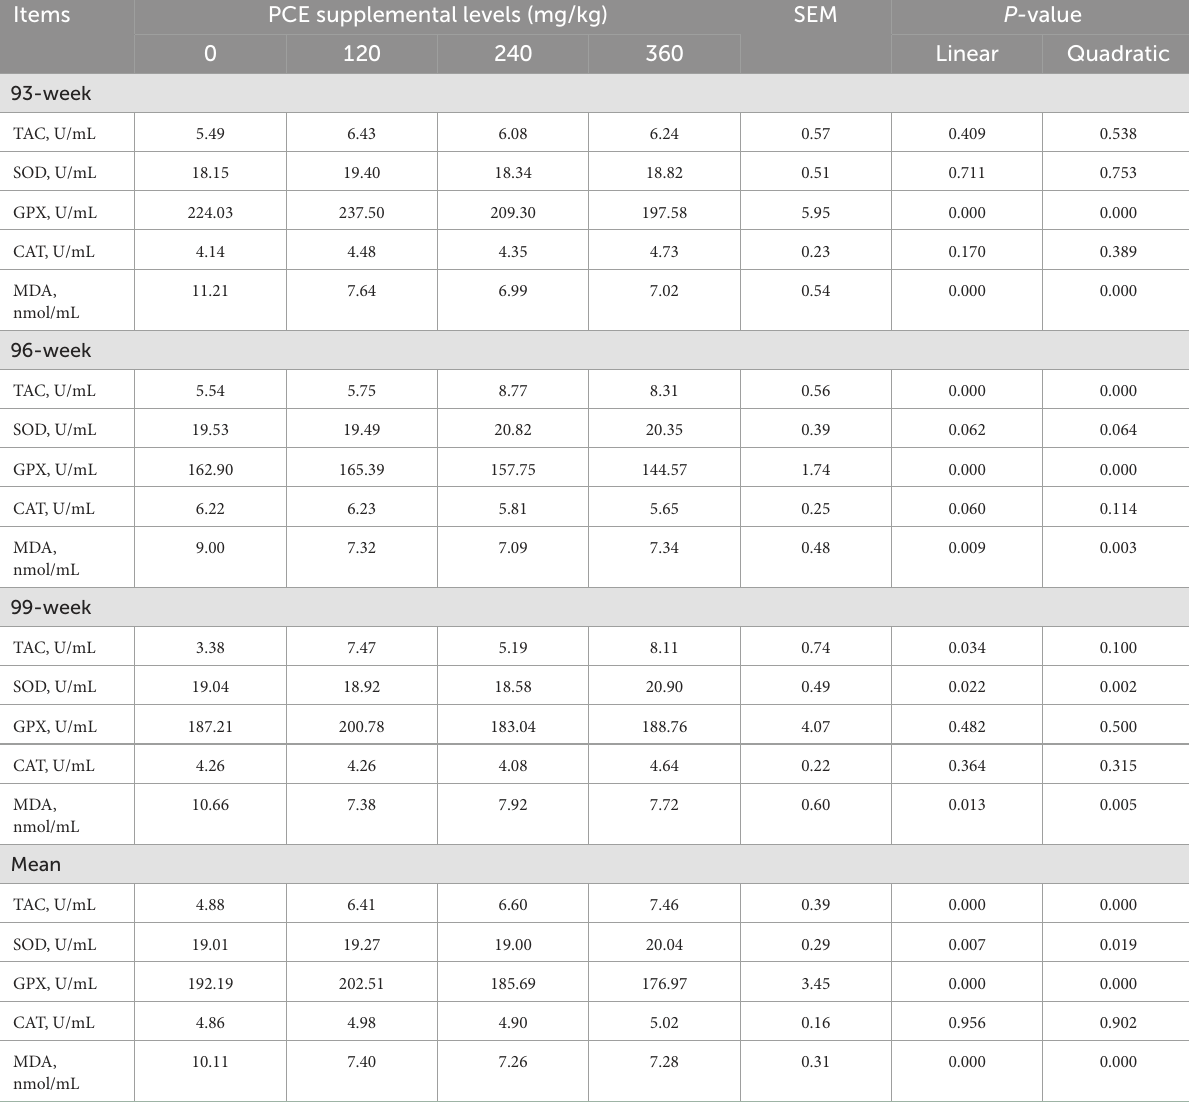
TABLE 3 Effect of purple corn extract on plasma antioxidant activity in laying hen.